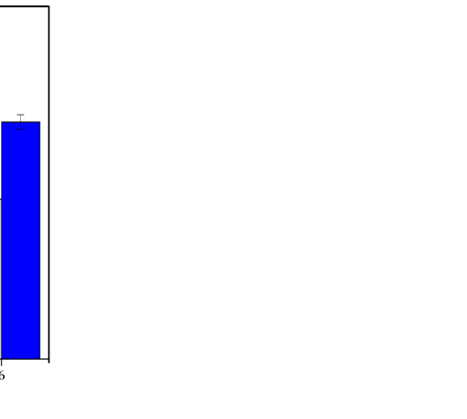
Figure 5. Effect of pH on the adsorption capacity ( C 0 = 100 mg/L, T = 25 °C, t = 8 h, n = 100 rpm).